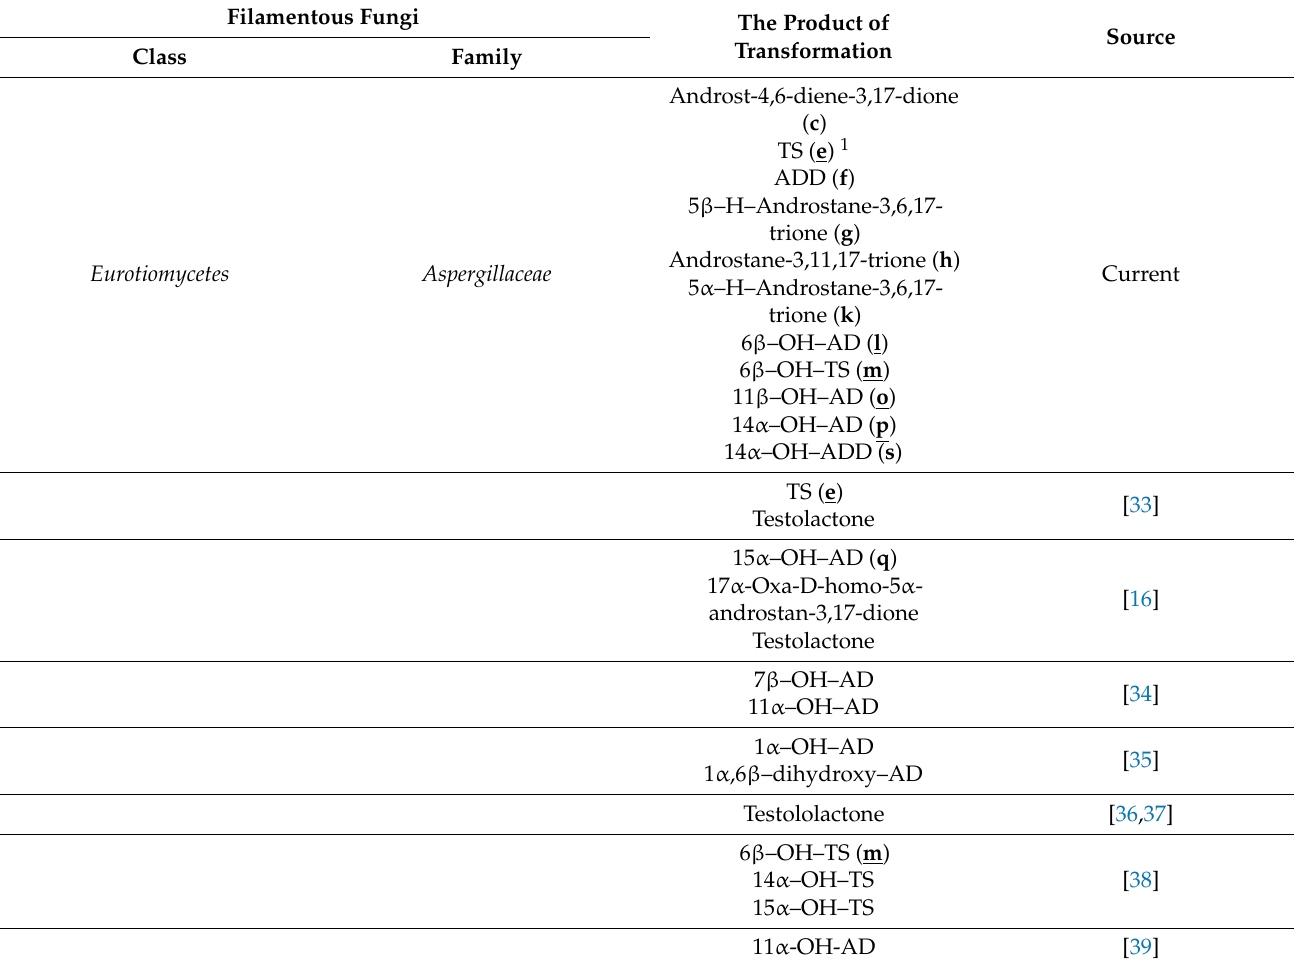
Table 2. Steroids formed as a result of AD (compound b ) transformation by filamentous fungi. Filamentous